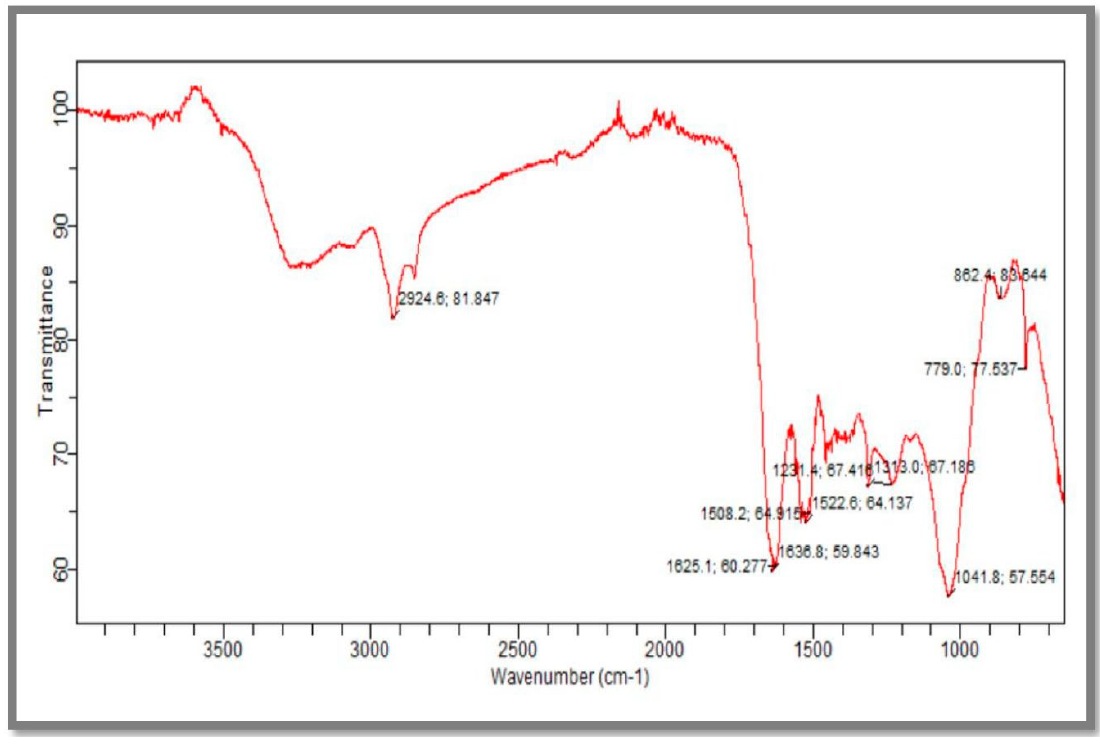
Figure-3. Fourier-transform infrared spectroscopy of synthesized nanoparticles to analyze func- tional groups responsible for the reduction of Ag ions.